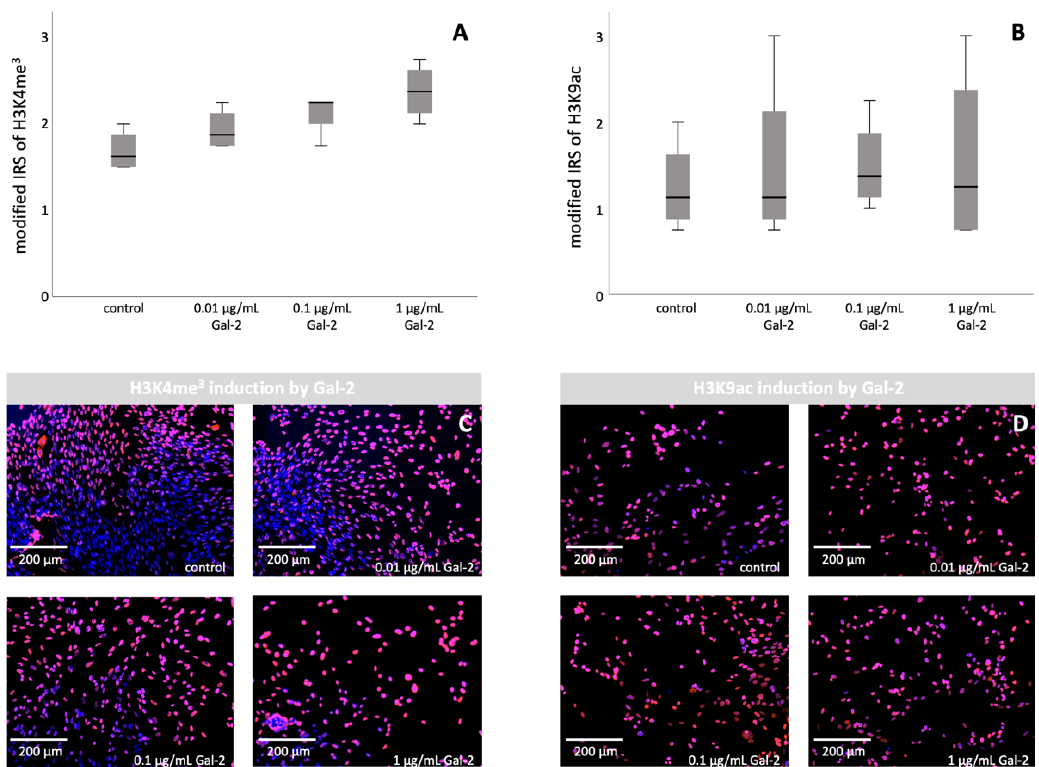
Figure 2. Induction of H3K4me 3 and H3K9ac by increasing the concentration of Gal-2 in HVT cells: staining results of immunocytochemistry of HVT cells. ( A , B ) Representation of the staining data as boxplots. ( C ) Representative images of the staining of H3K4me 3 after incubation with increasing Gal-2 concentrations. ( D ) Representative images of the staining of H3K9ac after incubation with increasing Gal-2 concentrations. Scale bar: 200 µm.